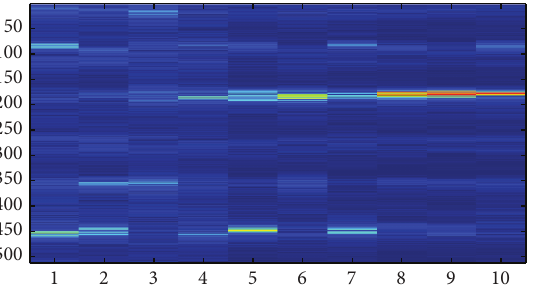
Figure 7: The row basis matrix obtained by 2DNMF.